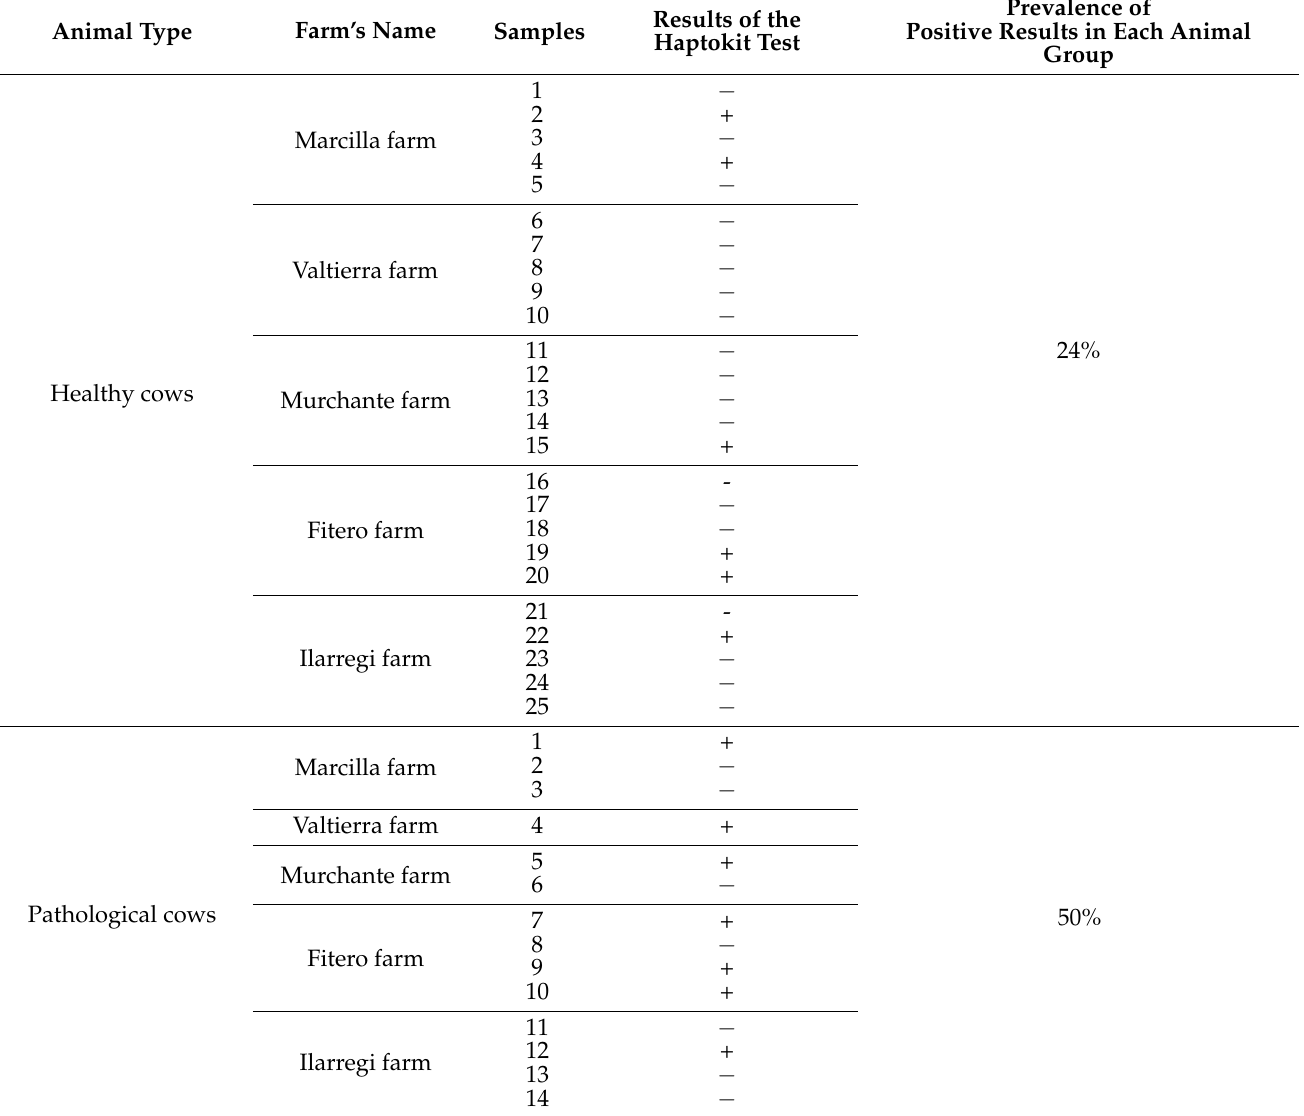
Table A2. Individual sample results for haptoglobin detection (>2 µ g/mL) with the Haptokit test. Prevalence of Results of the Animal Type Farm’s Name Samples Positive Results in Each Animal Haptokit Test Group